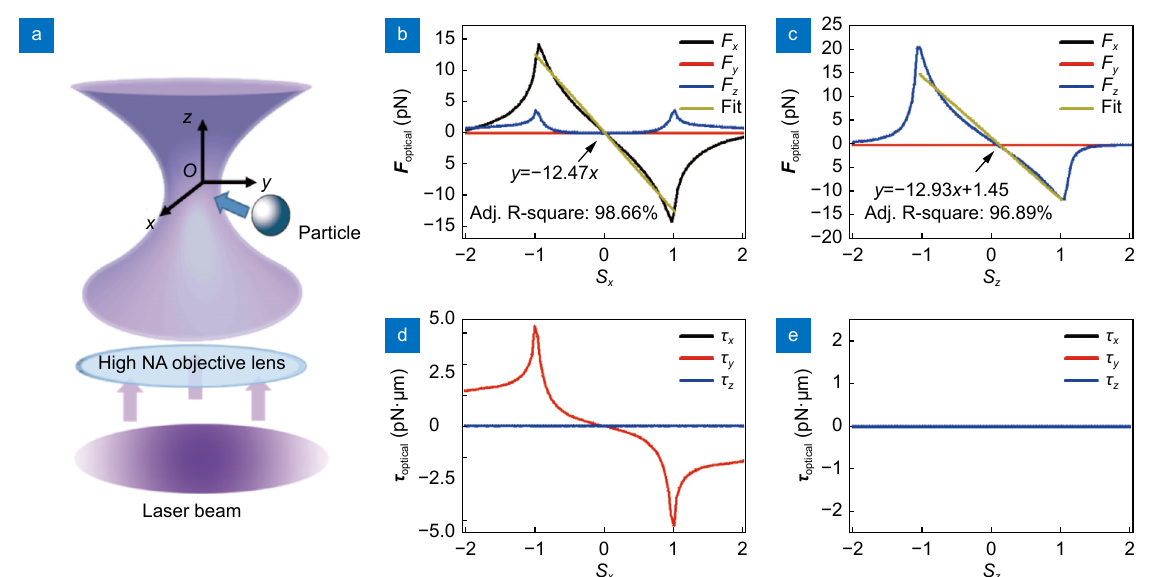
Fig. 1 | ( a ) Schematic of basic optical tweezers. A single laser beam is focused by a high numerical aperture objective lens to form a stable op- tical trap for microscale particle. ( b ) and ( c ) illustrate the calculated optical force acting on a micro-sphere when it moves along the x -axis and z - axis, respectively, in the optical tweezers at the laser power P = 10 mW. Here, the two most important features of optical tweezers are shown: the maximum reverse axial force that characterizes the strength of the trap, and spring constants (the slope of the fit line). ( d ) and ( e ) display the cal- culated optical torque acting on a micro-sphere when it moves along the x -axis and z -axis,